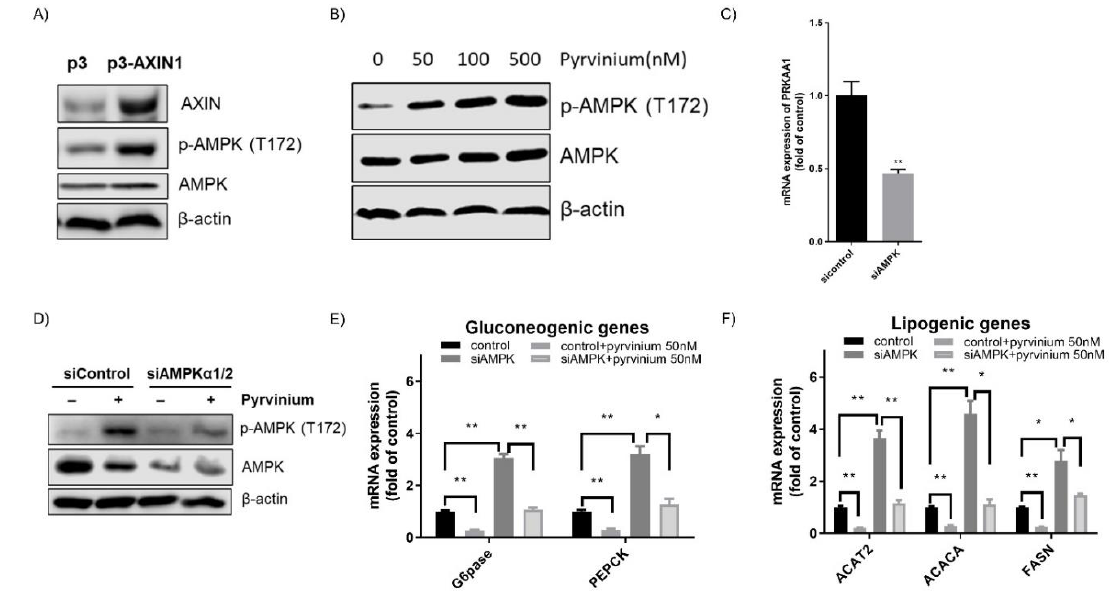
Figure 4. Role of AMPK activation in the effects of pyrvinium on gluconeogenesis and lipogenesis in Huh7 cells. ( A ) Effect of AXIN1 overexpression on AMPK phosphorylation in Huh7 cells. The cells were transiently overexpressed with the p3 plasmid containing AXIN1 gene. ( B ) Effect of pyrvinium treatment on AMPK phosphorylation in Huh7 cells. The cells were treated with varying concentrations of pyrvinium for 24 h. ( C ) The gene expression of PRKAA1 (encoding AMPK alpha 1) in Huh7 cells transfected with siRNA against PRKAA1 . ( D ) Protein expression of phosphorylated and total AMPKα in Huh7 cell transfected with siRNA against PRKAA1 . ( E , F ) Relative mRNA expression of gluconeogenic genes ( PEPCK , G6Pase ; ( E ) and lipogenic genes ( ACAT2 , ACACA and FASN ; ( F ) with or without knockdown of PRKAA1 , followed by treatment with 50 nM pyrvinium for 24 h. * p < 0.05; ** p < 0.01. Data are representative of at least three independent experiments.